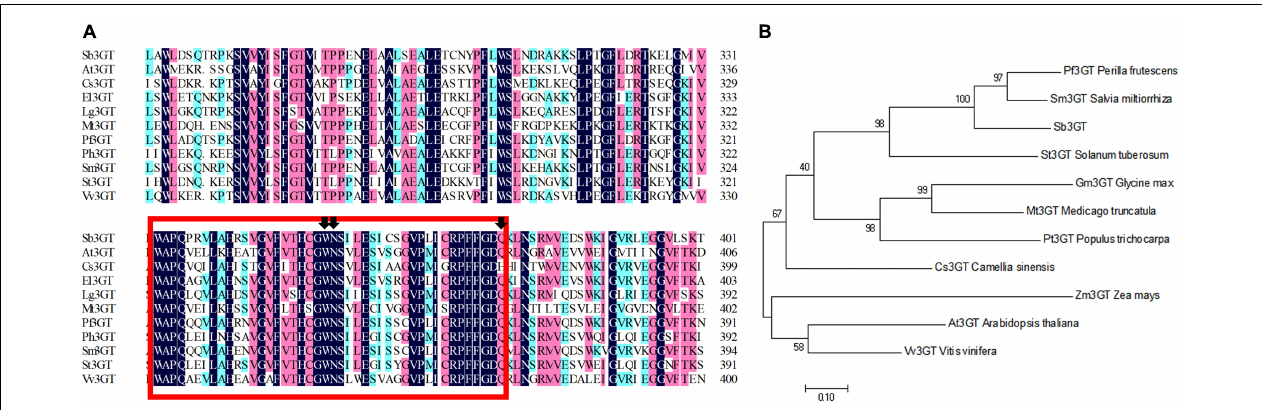
FIGURE 9 | Phylogenetic and multiple alignment analyses of the deduced amino acid sequence of Sb3GT protein from Scutellaria baicalensis and other species. (A) Multiple alignment of the proteins from selected species. A N-terminal-conserved plant secondary product glycosyltransferases (PSPG) domain is framed in a red box. The black arrow indicates the significant amino acid sites of 22, 23, and 44 in the PSPG domain. (B) Phylogenetic analysis of the Sb3GT proteins from S . baicalensis and other selected